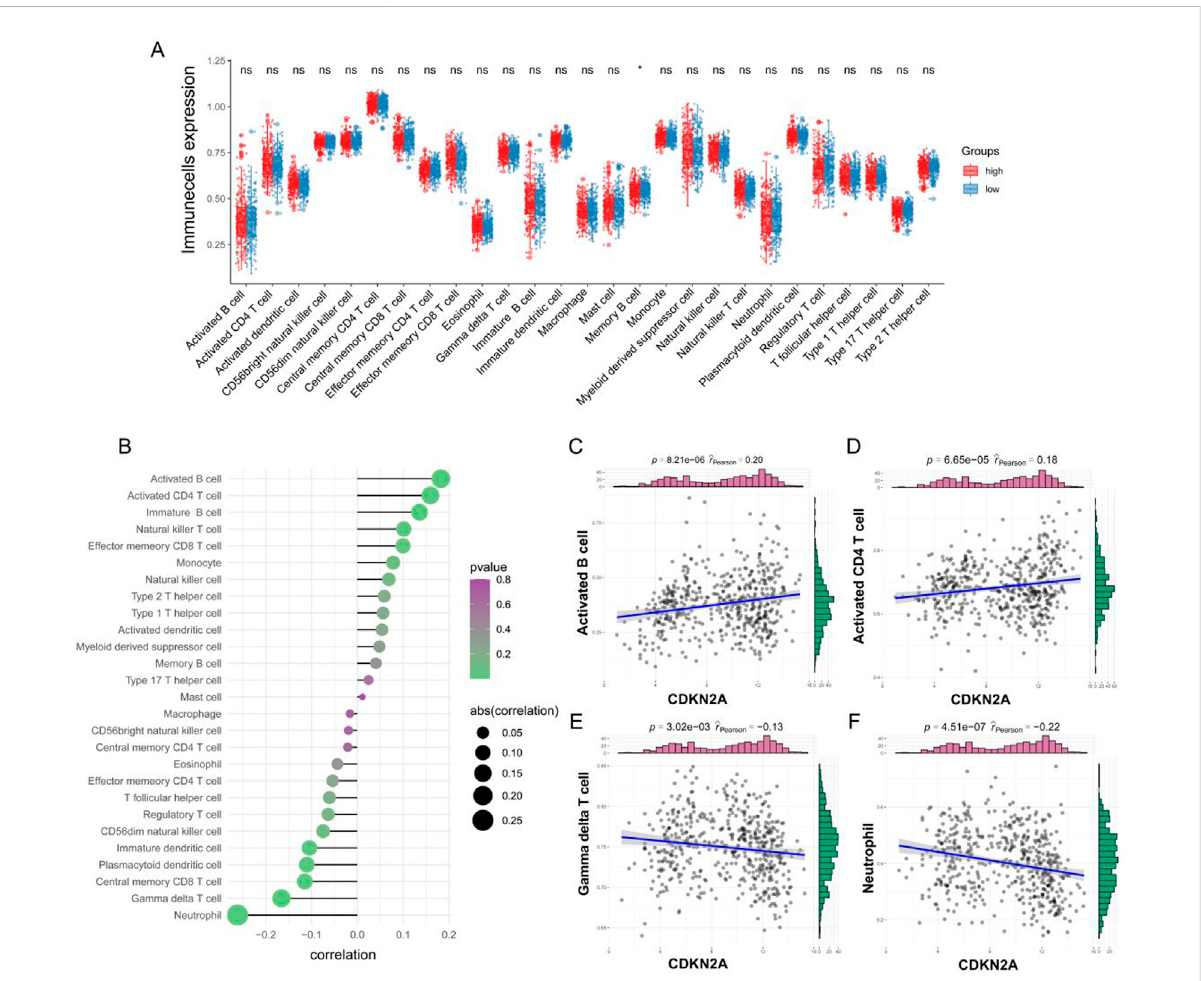
Correlation between CDKN2A and immune cells. (A) Differences in immune cell in fi ltration between the high- and low-CDKN2A-expression groups wereexamined via ssGSEA; (B) Correlation between CDKN2A and thein fi ltration ofimmunecells; (C – F) Correlation plots demonstratingthe relationship between the top four immune cell types and